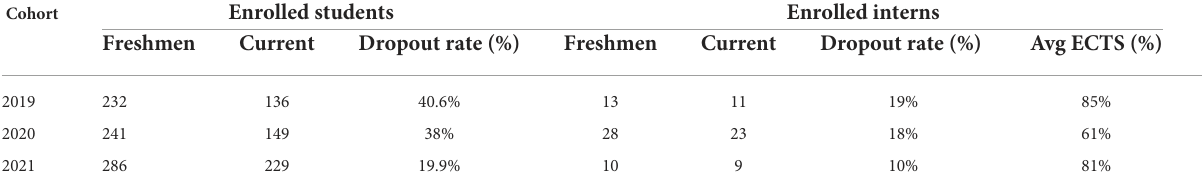
TABLE 5 Comparison of the number of enrollments, drop out rate, and careers of students and internship participants.